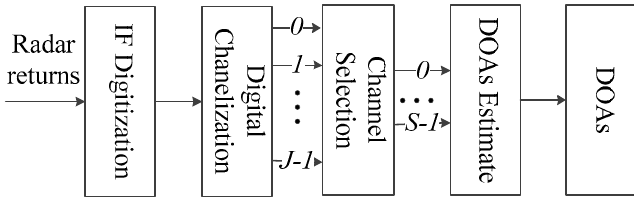
Figure 1. Flow of the proposed method.